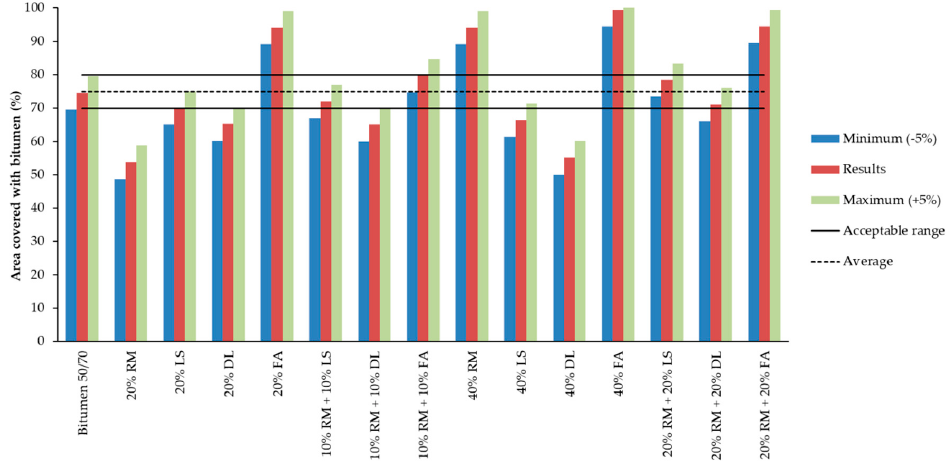
Figure 9. Covered area of aggregates considering a ± 5% range (without additive).